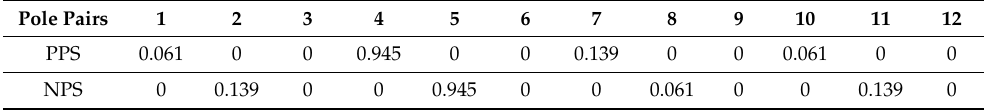
Table 2. Winding factors of the DSSR